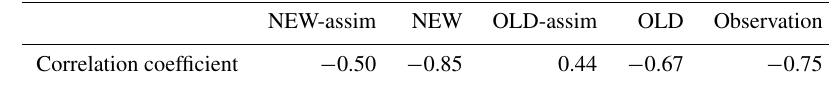
Table 1. Correlation coefficients between the detrended 1-year running mean NINO3-SST and NINO3-CO2F anomalies in NEW-assim, NEW, OLD-assim, OLD, and the observations. The correlations coefficients in NEW-assim, NEW, OLD-assim, and OLD are for the period from 1961 to 2005 (Figs. 1 and S2), and the correlations coefficient in the observations is for the period from 1982 to 2005.